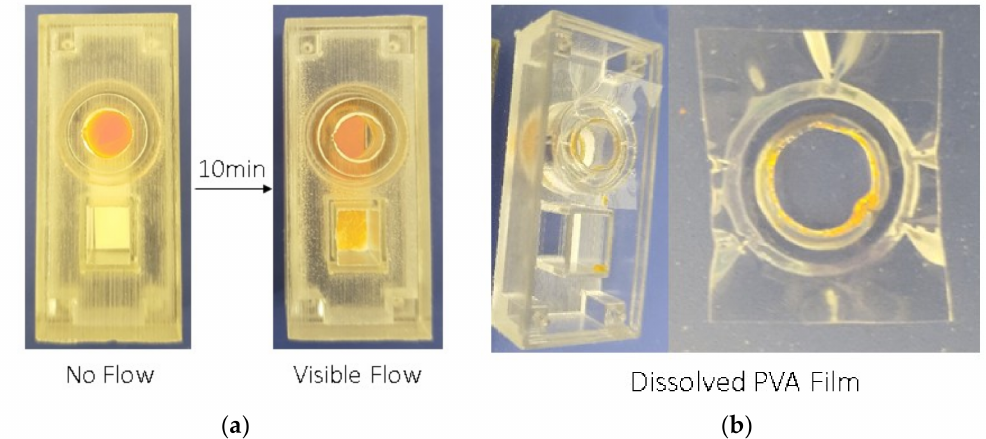
Figure 2. Control of sample flow. ( a ) Integration of a PVA film inside the customized 3D-printed holder, after applying ink sample, there is a visible delay of flow. It is clear to identify the sample flow after 10 min of waiting time. ( b ) Dissolved PVA film, after applying the ink sample and allowing for a waiting time of 30 min for full sample